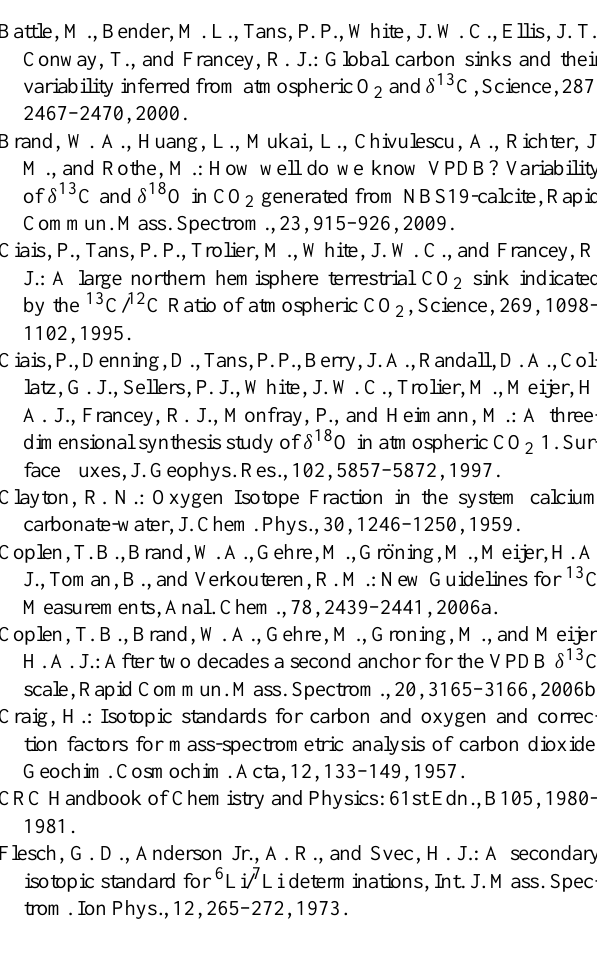
Fig. C1. Isotopic compositions of pure CO 2 in a high-pressure cylinder (APB2) over a period of time of more than 10yr (1998–2011). Top Figure C-1. Isotopic compositions of pure CO panel: δ 13 , bottom panel: δ 18 O VPDB-CO . The numbers indicate the pressure readings at the time of IRMS analysis. The results CVPDB-CO 2 2 show that the isotopic compositions were more stable below the pressure of ∼ 800 PSI, when all CO 2 becomes gaseous period of time of more than 10 years (1998-2011). Top panel:  13 C . The numbers indicates the pressure readings at the time of IRMS analysis. The 640  18 O VPDB-CO2